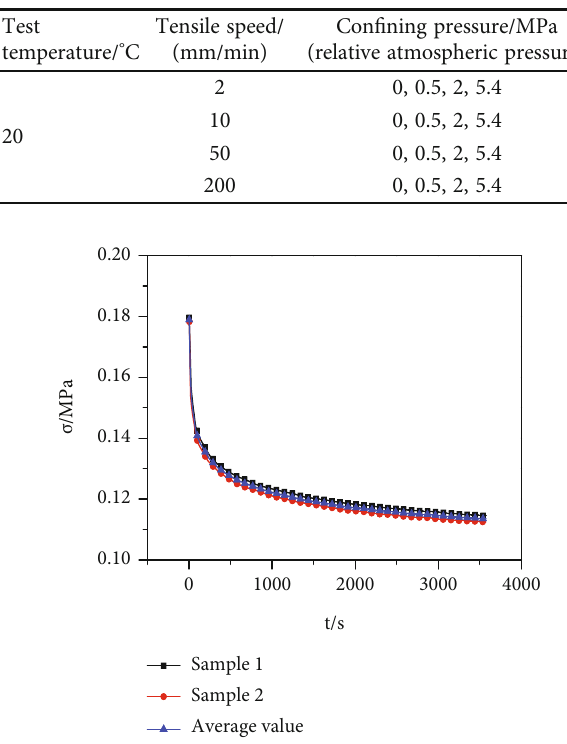
Figure 4: Test results of N15 propellant relaxation at room